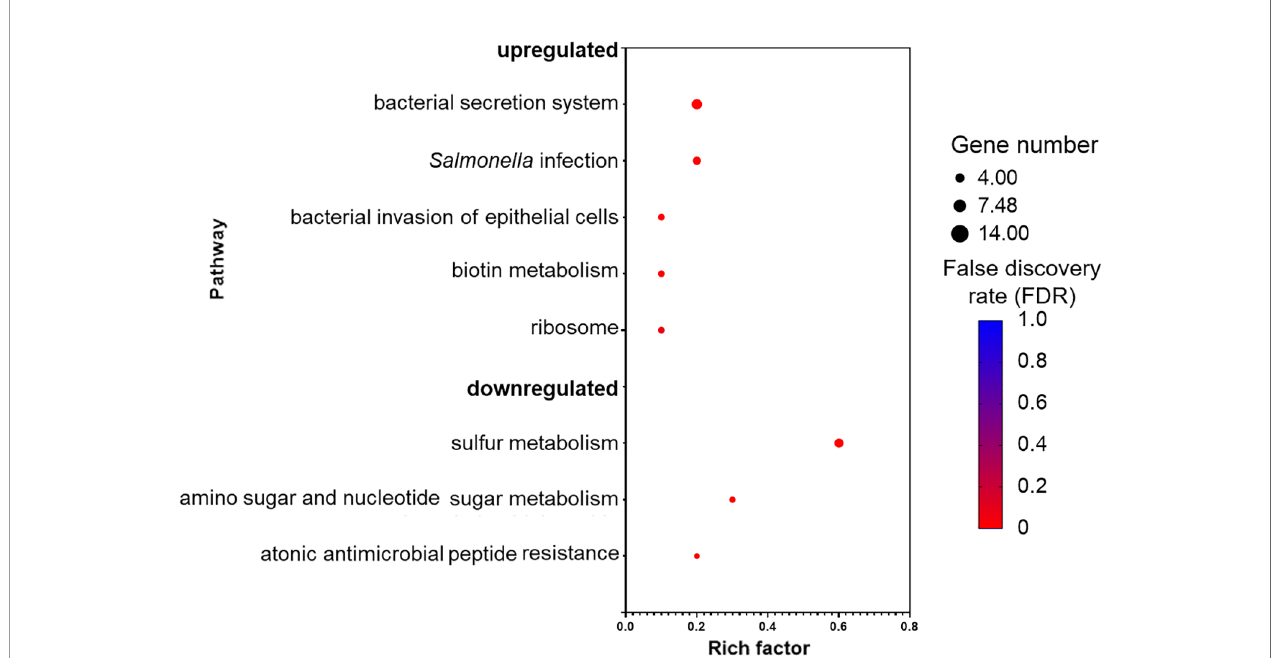
FIGURE 5 | Pathways that are upregulated and downregulated as analyzed by Kyoto Encyclopedia of Genes and Genomes (KEGG). Each pathway is represented by a dot; the size, color, and rich factor value of the dot represent the total number of the genes within the pathway, false discovery rate, and proportion of genes in the pathway considered as core enrichment,